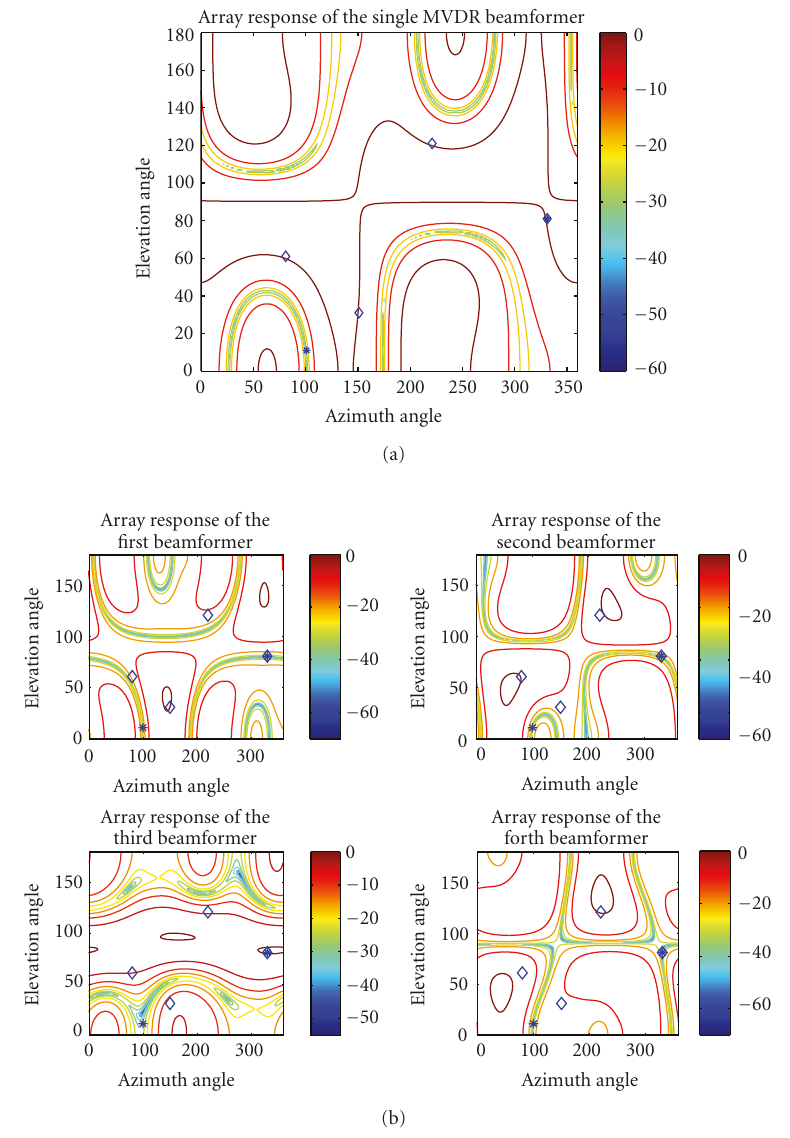
Figure 9: (a) Array response of the adaptive single MVDR beamformers with two RHPC jammers where one is aligned with one of the GPS satellites. (b) Array response of the adaptive multiple MVDR beamformers with two RHPC jammers where one is aligned with one of the GPS